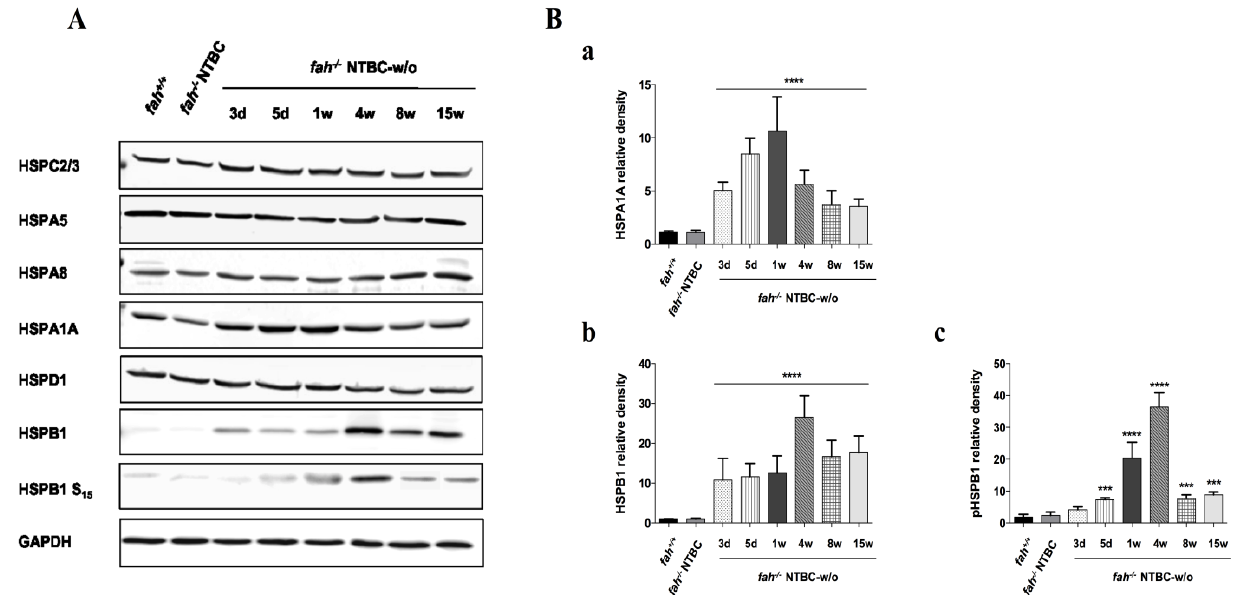
Figure 8. Western blot analysis of heat shock proteins. ( A ) Variation in the levels of anti-apoptotic HSPB1 and HSPA1A, in liver of fah +/+ , fah −/− NTBC-treated and fah −/− NTBC-off mice. HSPC2/3, HSPA5, HSPA8 and HSPD1 were also tested as HSP family members. Data are representative of at least two different experiments with four biological replicates; ( B ) Histograms show quantitative representation of the level of HSPs proteins after normalization to levels of GAPDH and the fold-change protein level expression is reported in comparison to fah +/+ mice. Data are mean ± standard deviation for four samples. Significance of group differences was evaluated using ANOVA for multiple comparisons (*** p < 0.001 and **** p < 0.0001). Where statistical significance was not observed after densitometric analysis, graphics were not produced ( i.e ., HSPC2/3, HSPA5, HSPA8,